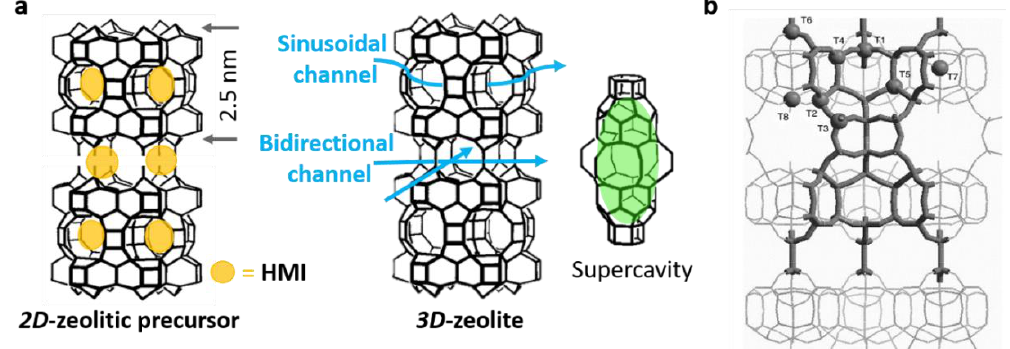
Figure 1. The two-dimensional (2D) zeolitic precursor and three-dimensional (3D) MWW (Mobil twenty two) zeolitic structure ( a ); its eight different tetrahedral sites ( b ); HMI (hexamethyleneimine). Adapted from Reference [14,15]. Copyright (1998), with the permission of the Royal Society of Chemistry, and Copyright (2006), with permission from Elsevier. (2006), with permission from